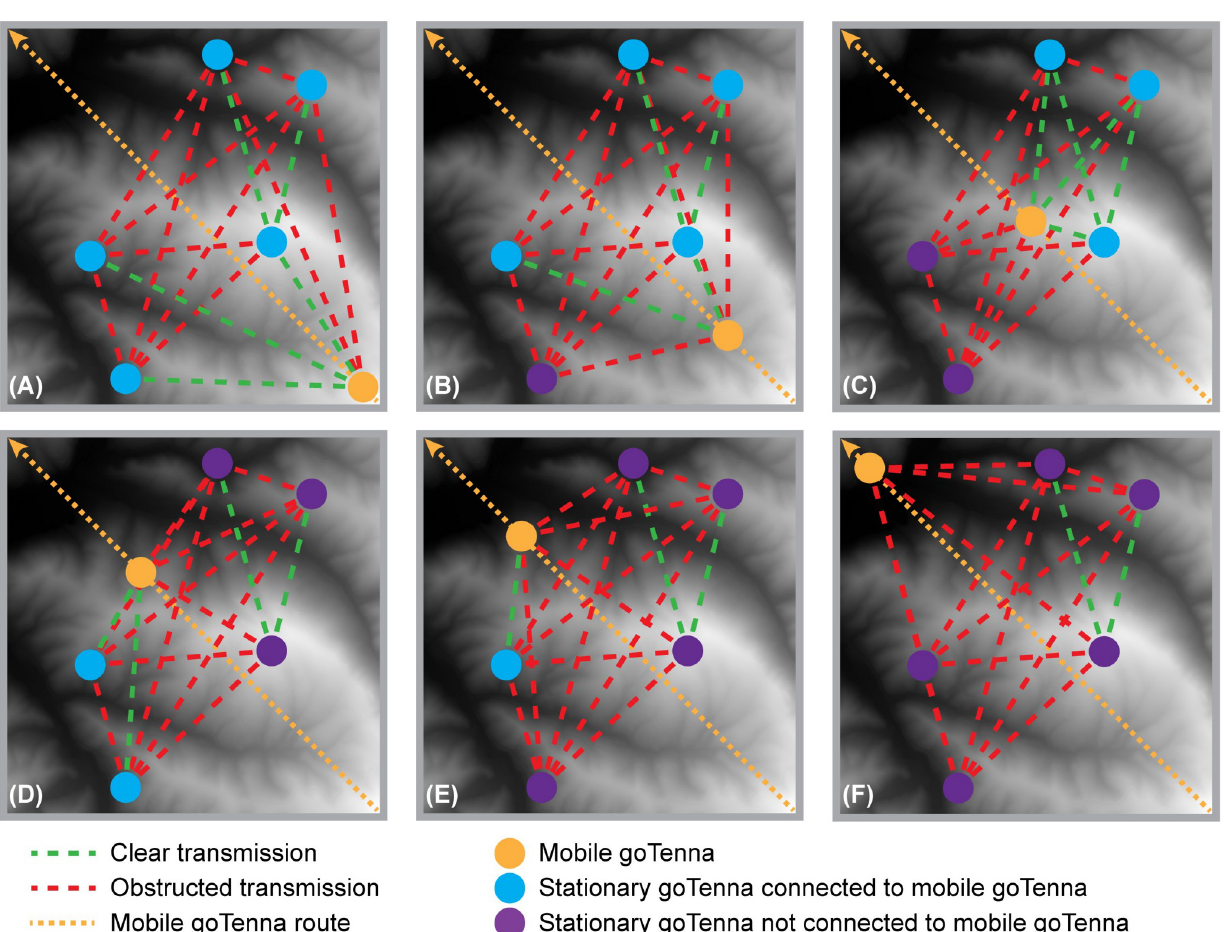
Fig 3. Example locations of the one mobile and five stationary goTenna Pros that may result in each of the six connectivity levels. The mobile goTenna is shown at various locations along the diagonal walking path within a PLSS section. Panels A–F represent connectivity levels Con_6–Con_1, respectively. These connectivity levels correspond to instances in which five, four, three, two, one, or zero stationary devices are connected to the mobile goTenna Pro, respectively.